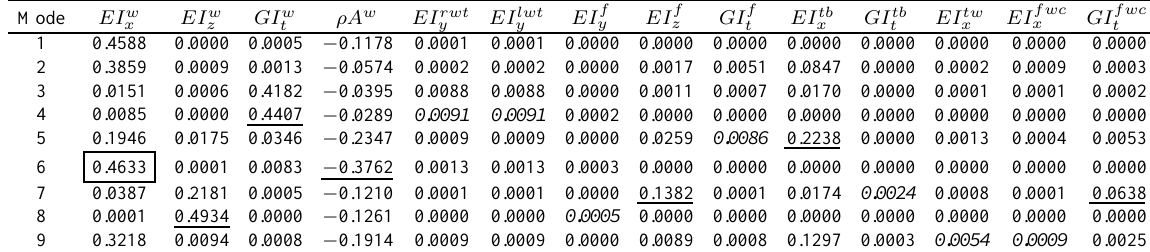
Table 2 Sensitivity matrix of natural frequencies to model properties